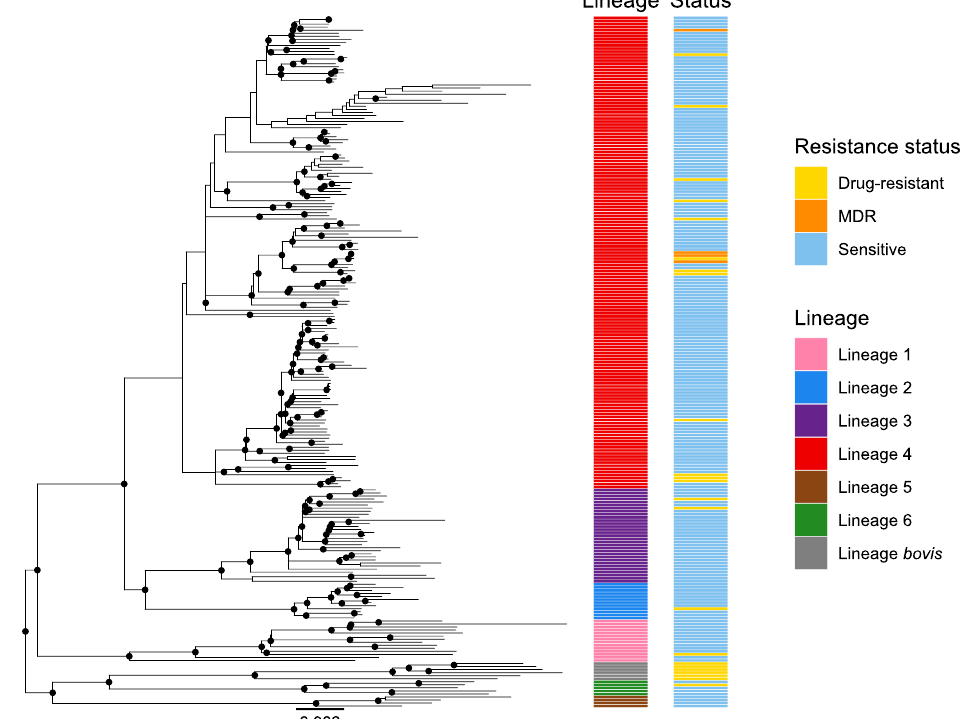
Figure 1. Global phylogeny of 227 whole-genome sequenced MTBC strains. The color codes are: pink—lineage 1, blue—lineage 2, purple—lineage 3, red—lineage 4, brown—lineage 5, green—lineage 6, gray— M. bovis lineage. The resistance status is represented for each strain with the following color code: blue—susceptible strains, yellow—strains resistant to one of the first-line drugs, orange—MDR strains (resistance to rifampicin and isoniazid). Only resistances to first-line TB drugs were considered here. MDR: multidrug-resistant.